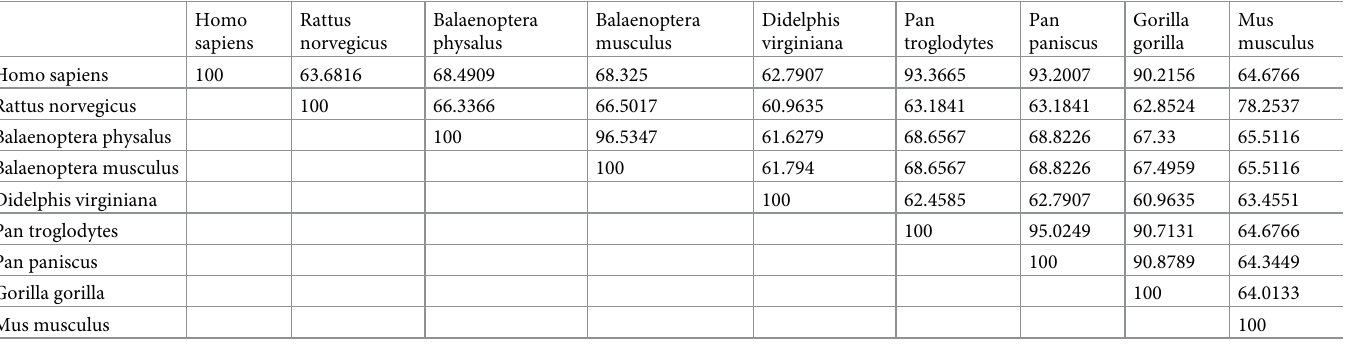
Table 4. The parameter Identity of the Smith-Waterman algorithm in the quantitative measurement of homology. The Identity reports the number of exactly matched characters of two compared sequences (in percentage) aligned by the HELIOS method, assuming the “Nine ND5 protein sequences dataset” [53].